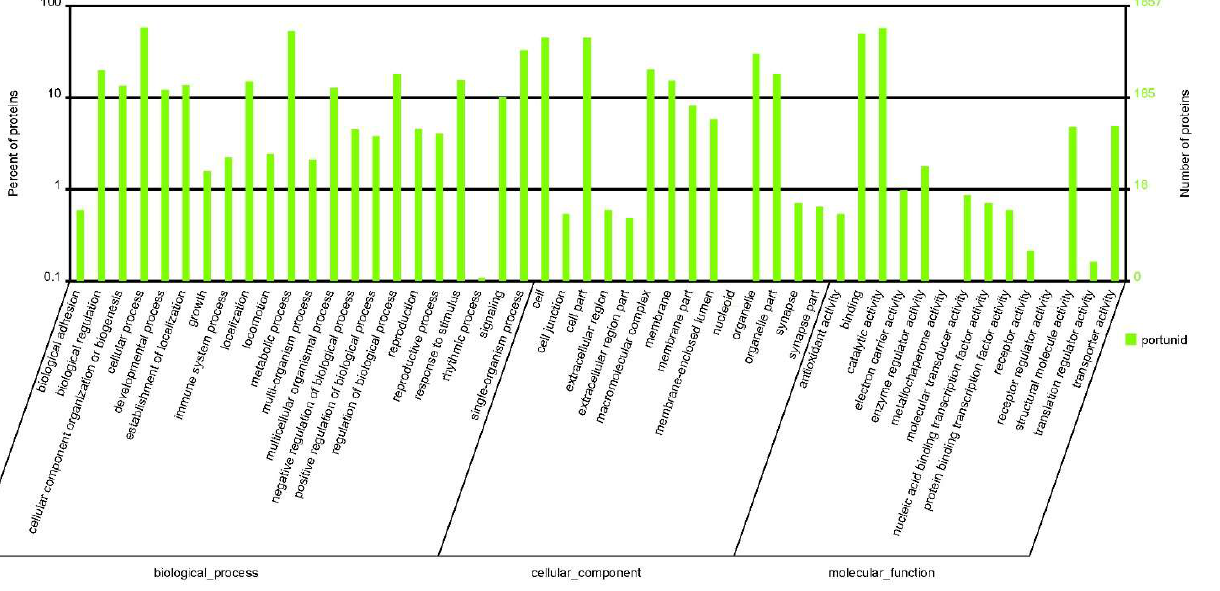
Figure 2. Gene Ontology analysis of the identified proteins in hemocytes. These proteins were classified into different categories based on three major ontologies, including biological processes, molecular functions, and cellular components.